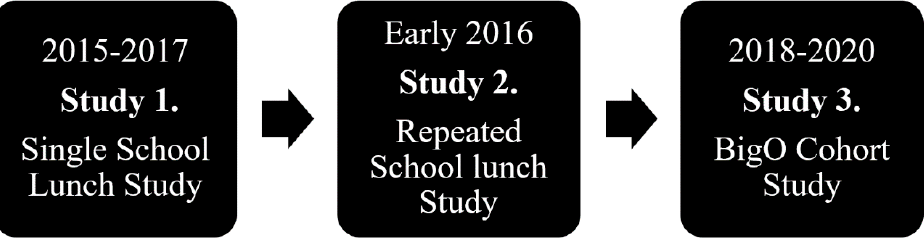
Figure 1. Timeline for studies 1–3.